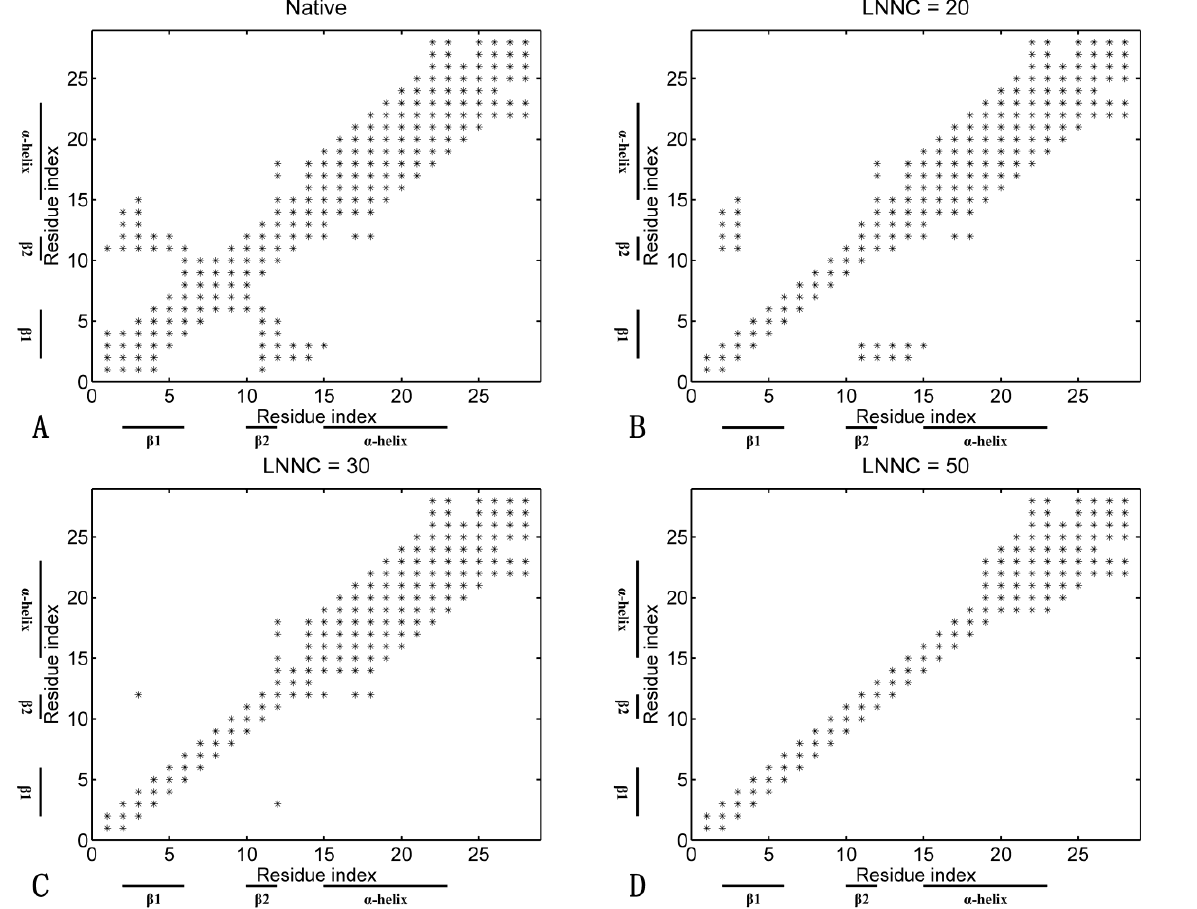
LNNC to be 20 ( B ), 30 ( C ) and 50 ( D ) for FSD-1, respectively. Each native contact is marked by the symbol * in the